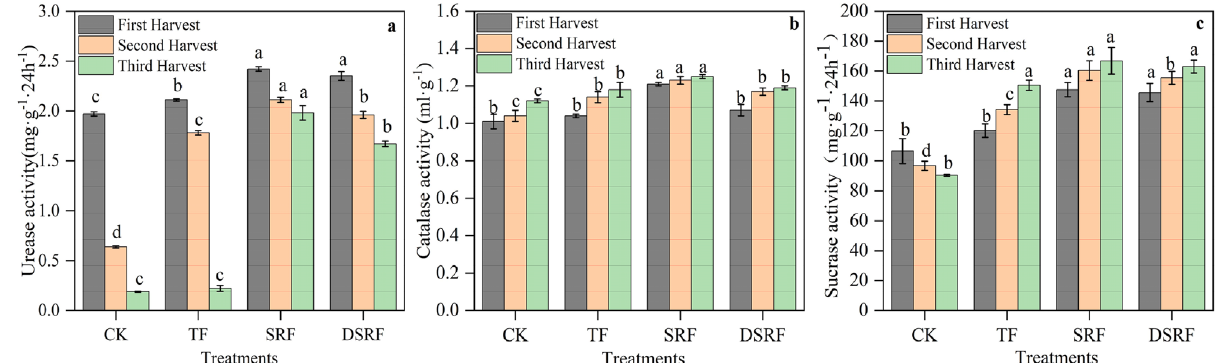
Figure 6. Soil urease activity ( a ), soil catalase activity ( b ), and soil sucrase activity ( c ) of wintering Chinese chives as affected by different fertilizer treatments. Lowercase letters indicate significant differences among